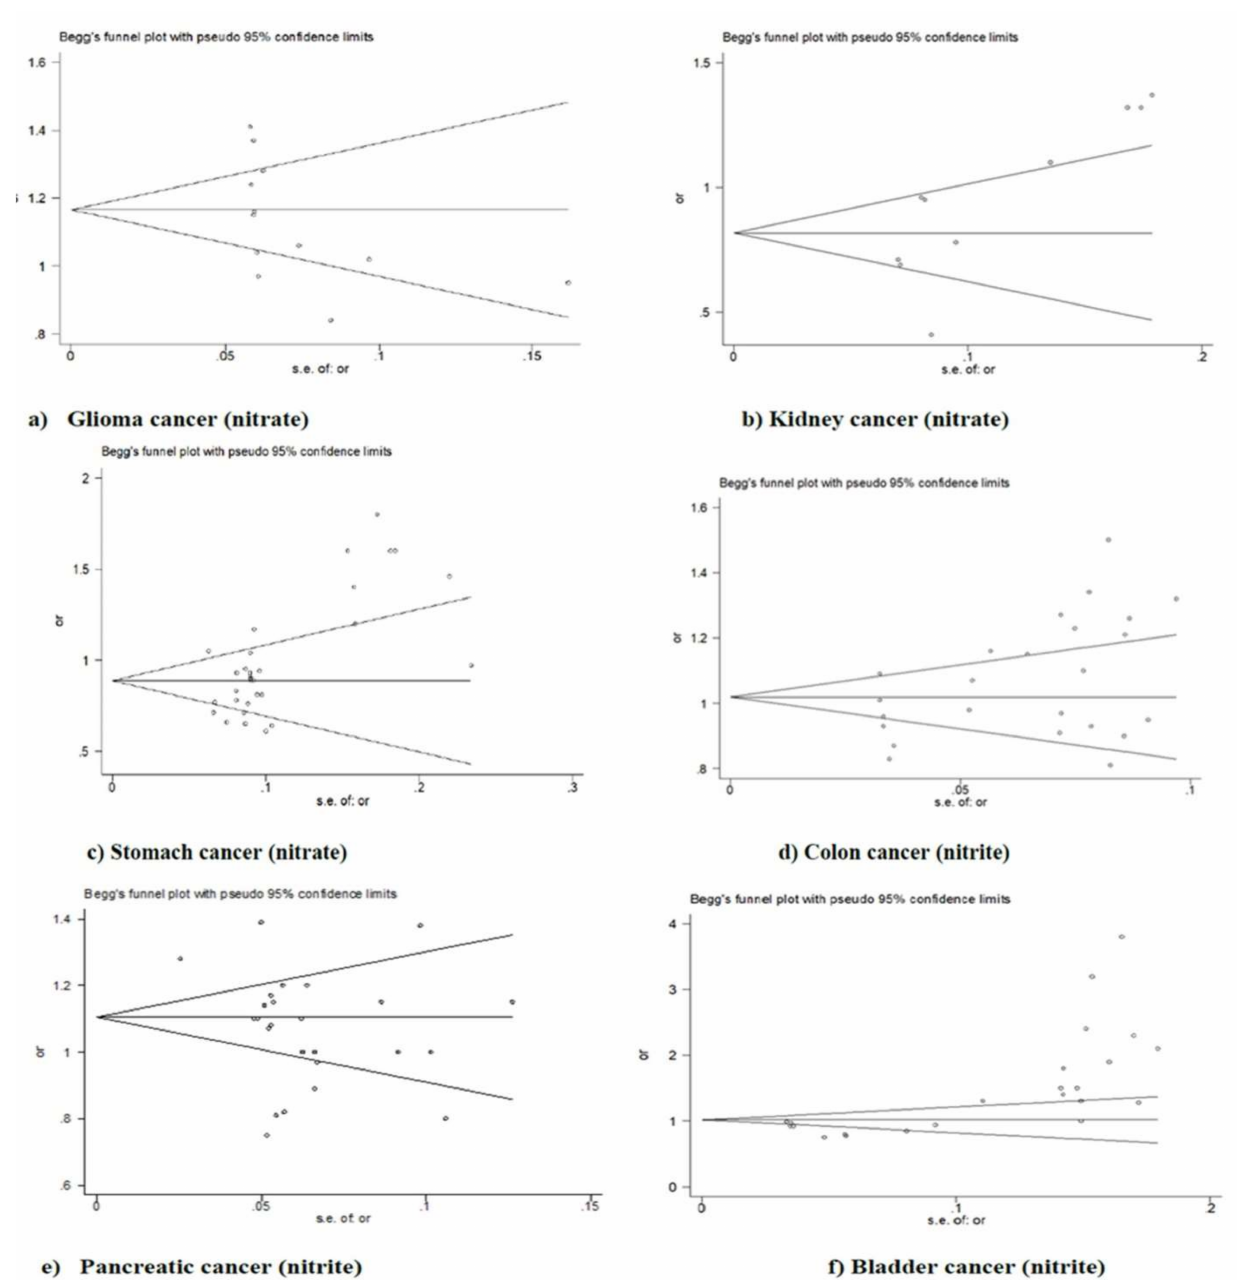
Figure 5. Funnel plot of nitrates and ( a ) glioma, ( b ) kidney, and ( c ) stomach cancer risk; nitrites and ( d ) colon, ( e ) pancreatic and ( f ) bladder cancer risk for publication